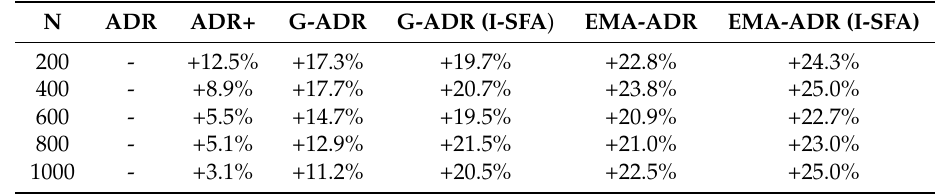
Table 6. PSR improvement for static